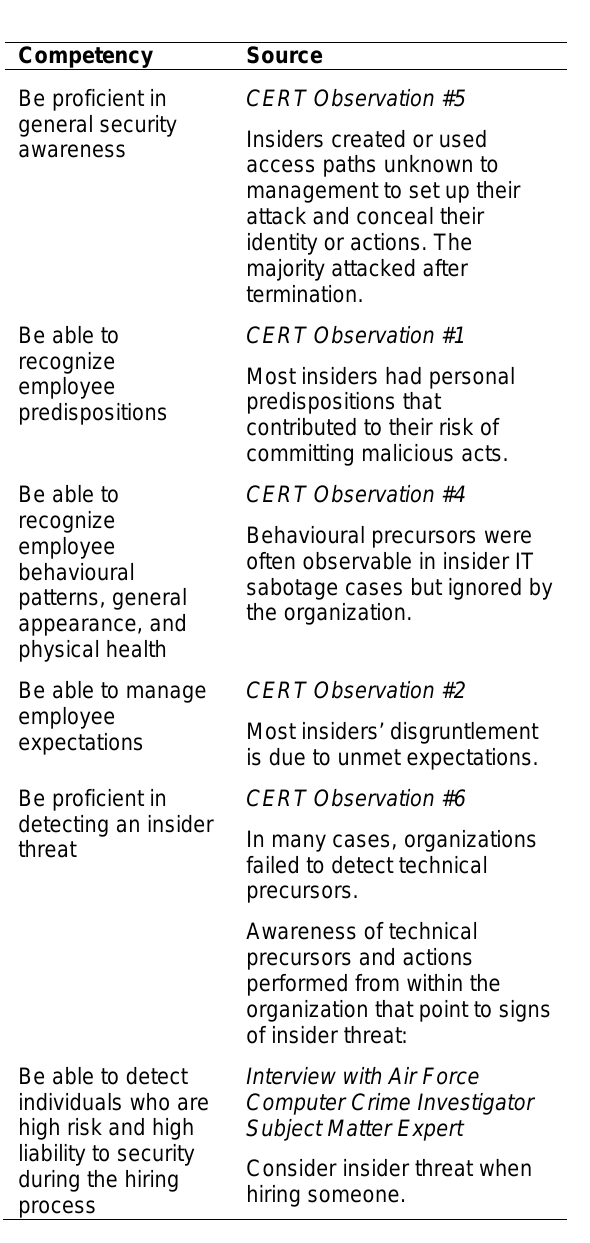
Table 1. Insider threat competency model. Table 1: Comparison of original and revised competency models for insider threat